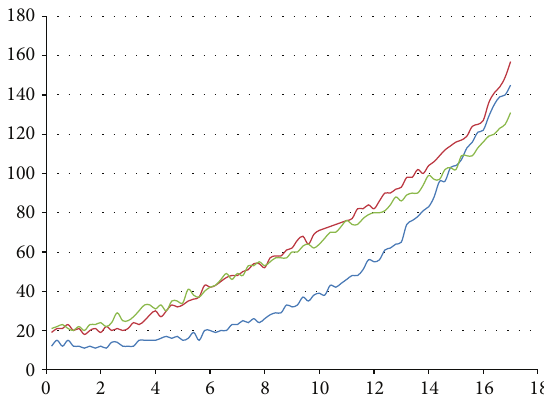
Figure 8: The fluorescent intensity of Output strands from exper- iment (A2). 𝑥 -axis is reaction time and 𝑦 -axis is the fluorescent intensity of 6-FAM. From bottom up, the curves correspond to cases of concentrations of Fuel strands being 80 nM (blue), 160nM (green), and 1.28 𝜇 M (red),